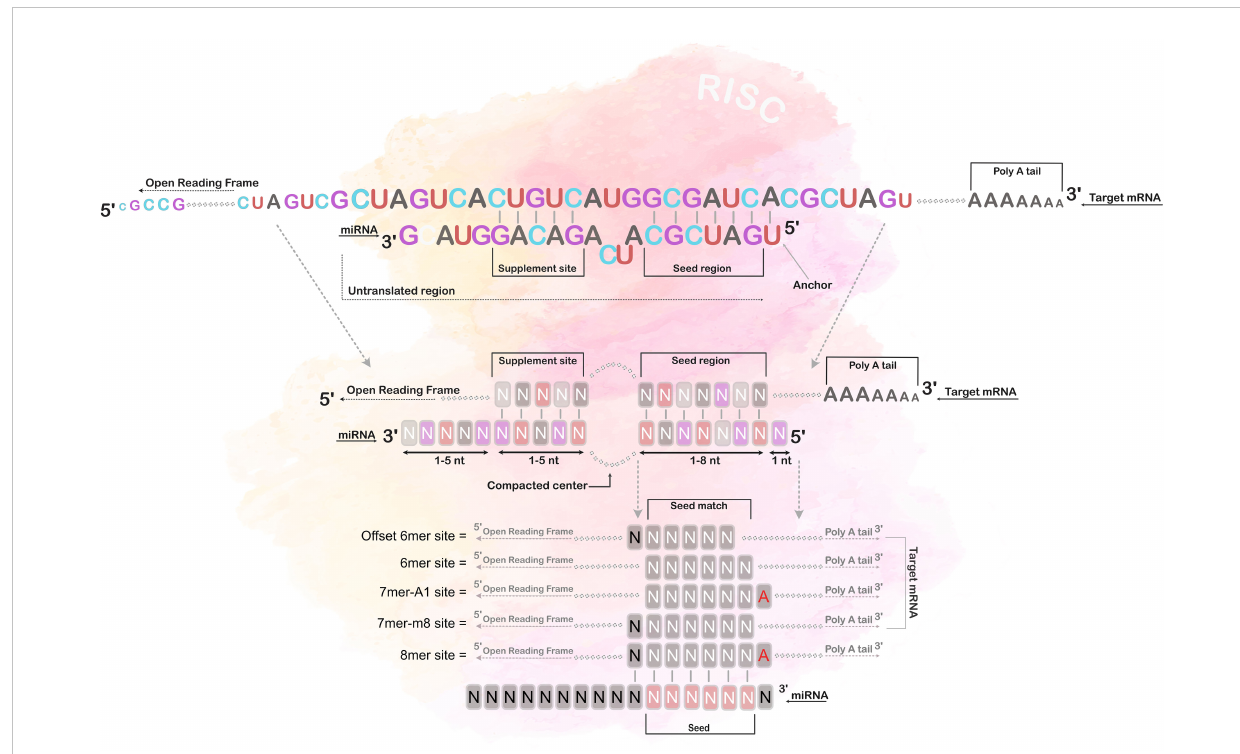
FIGURE 3 Seed region matching. The fi gure illustrates the different types of canonical site paring between the miRNA and its mRNA target, i.e. 8mer, 7mer-1A, 7mer-m8 and 6mer paring. The 8mer paring has a complete matched seed region of 7 bases, including an additional match at the 8th position, and an adenine opposite of the fi rst position; the 7mer-1A has a match between position 2-7 and an adenine opposite of the fi rst position; the 7mer-m8 has a match between position 2-8, and the 6mer has a match only in position 2-7. Notably, most miRNAs also have additional pairing beyond the seed region, called 3 ’ -supplementary